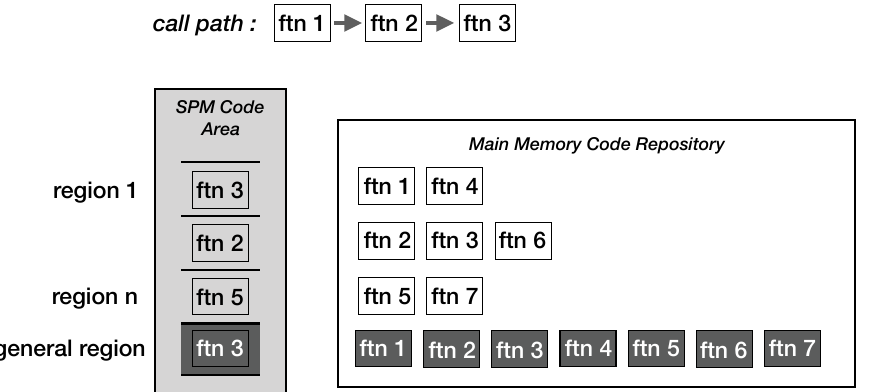
Figure 12. Code management with extended SPM code